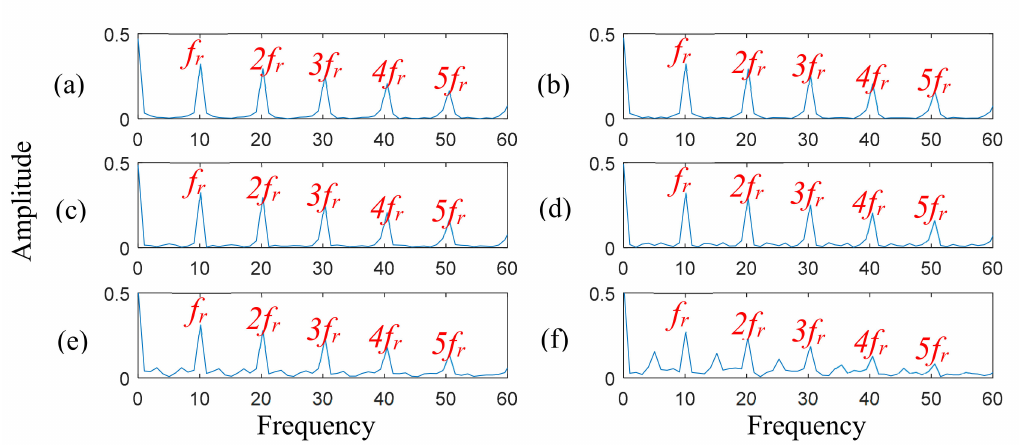
Figure 11. The faulty features with square envelope analysis, ( a ) no noise, ( b ) 10 dB, ( c ) 5 dB, ( d ) 0 dB, ( e ) − 5 dB, and ( f ) − 10 dB of noise.